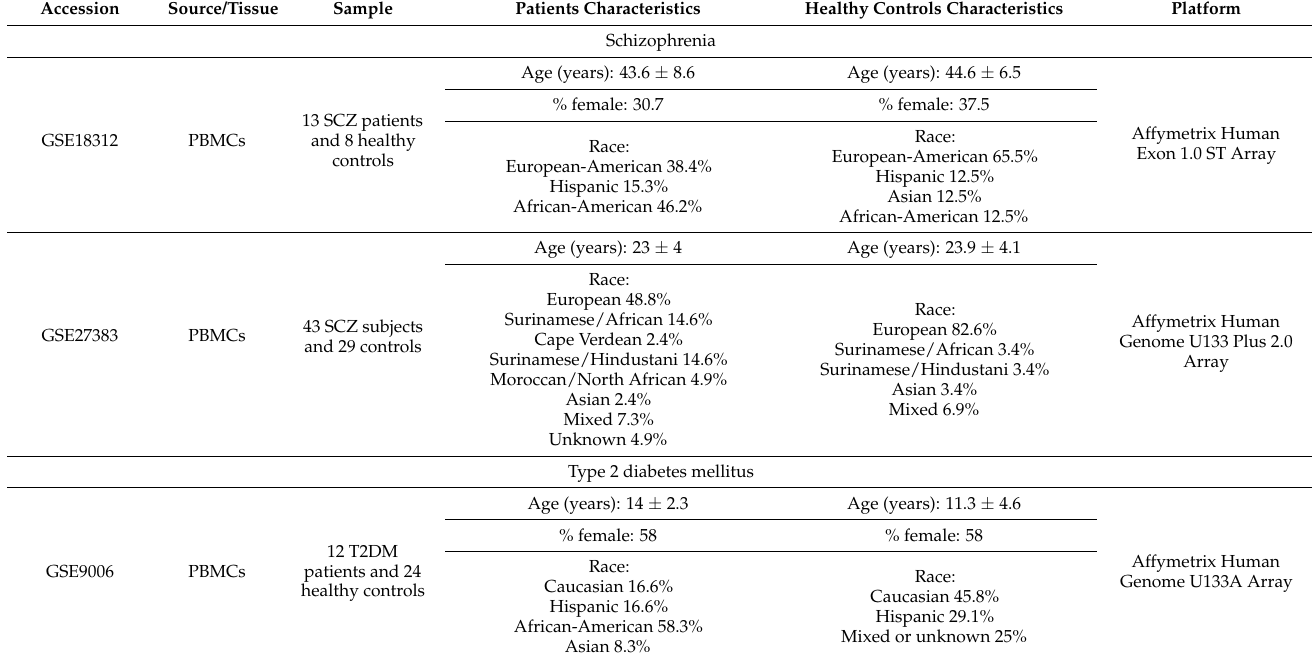
Table 1. Characteristics of the datasets used in this